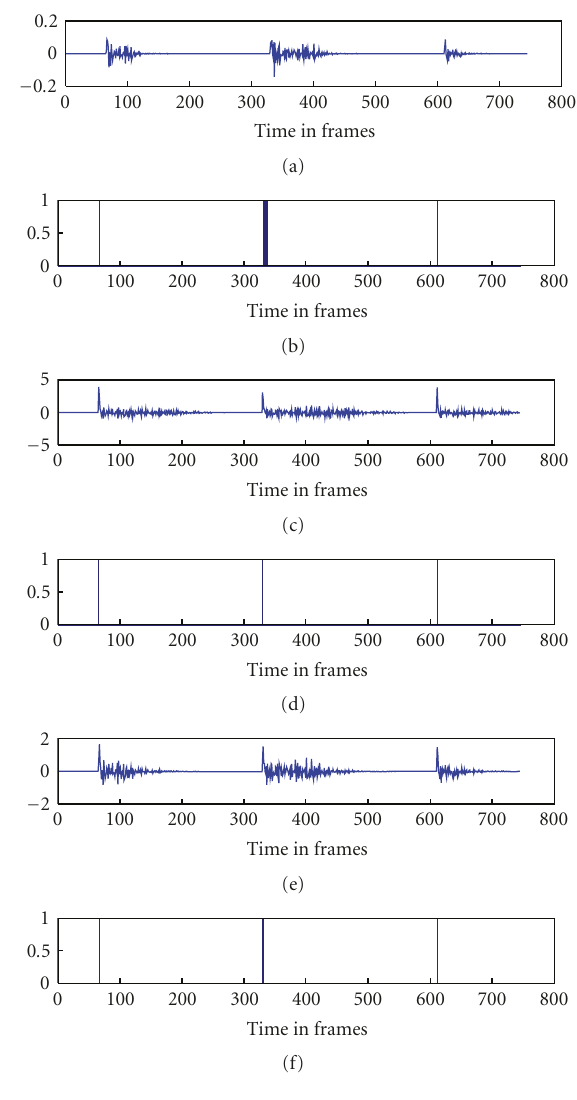
Figure 17: Increasing the threshold used for localisation of the onsets can improve the robustness against the instrumental dynamics. In this example, the threshold is set to 0.6 for onset detection of the gunshot signal (see Figure 9(b)). Plots (a), (c) and ( k ), h o ( k ), and h o ( k ), respectively, and (e) are detection functions h o a r b plots (b), (d), and (f) are the onsets localised correspondingly using these detection functions. This figure is in contrast to Figure 11, where the threshold is set to